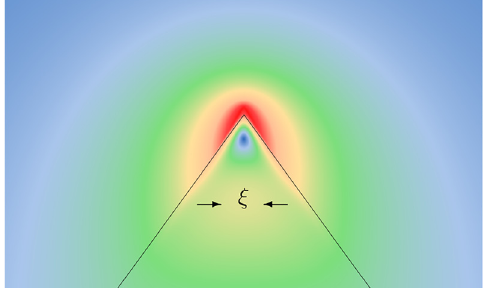
Figure 5: Typical electrical-field intensity for the plane-wave electromagnetic excitation of an arbitrarily sharp metallic tip. The nonlocal response serves to smear out the diverging field of the otherwise singular geometry. The results are obtained with the aid of a finite-element method implementation of the hydrodynamic model. Figure adapted from Ref. [169] ( © 2012 AIP